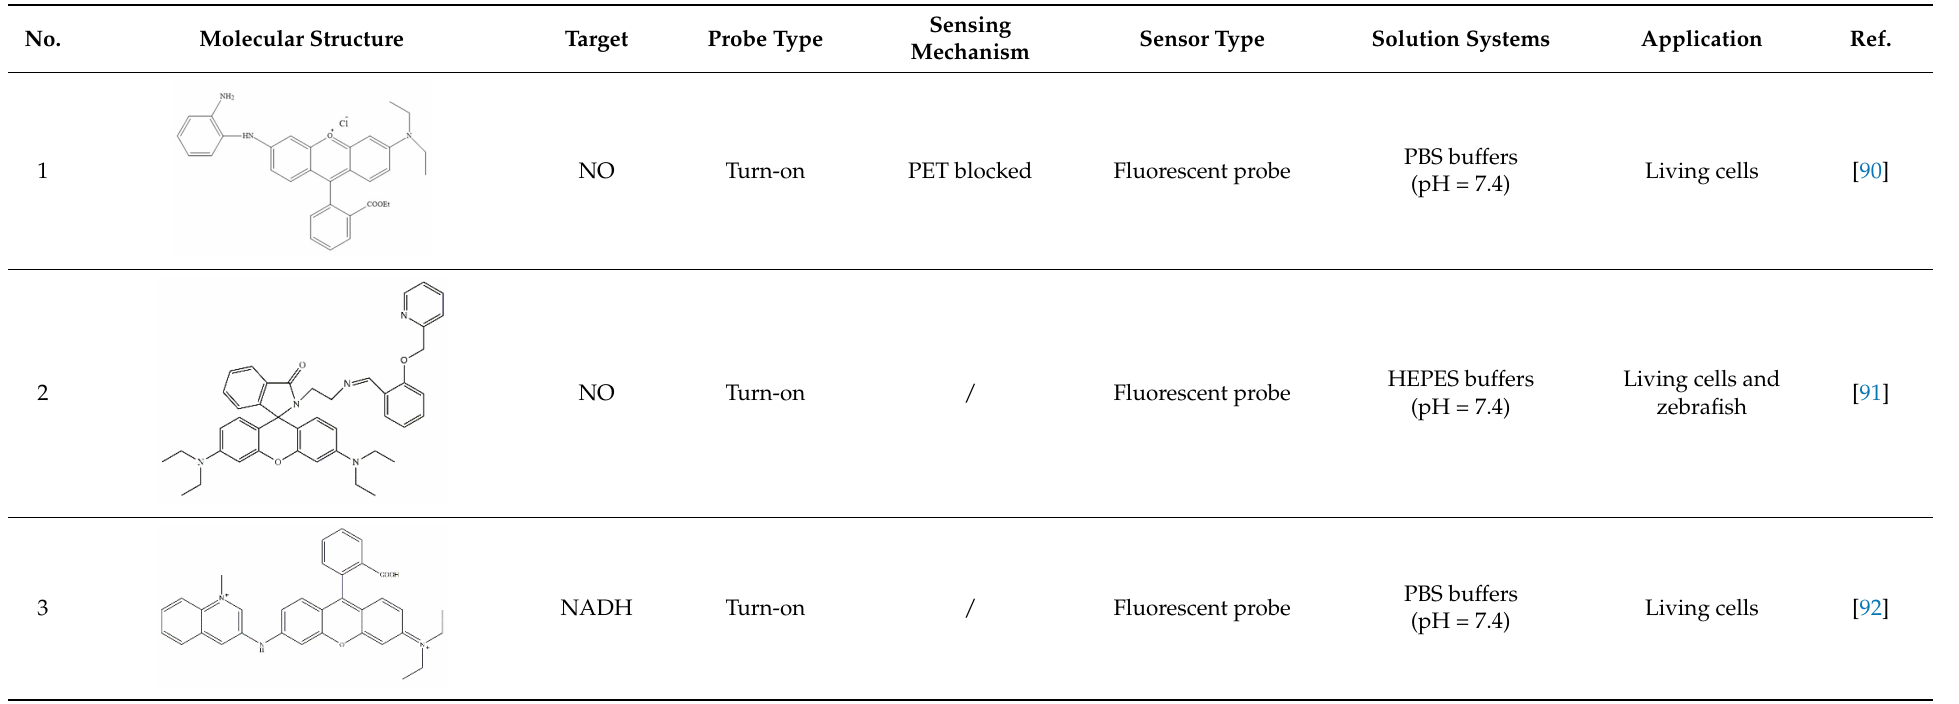
Table 3. Rhodamine-based sensors for anions and